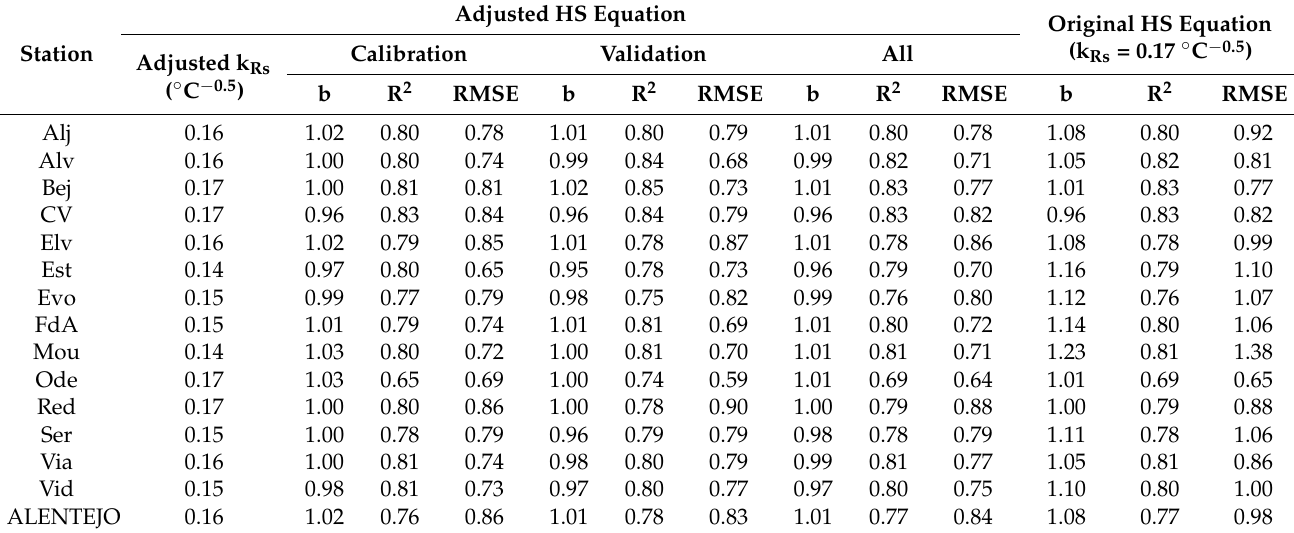
Table 4. Accuracy of daily reference evapotranspiration estimations using the Hargreaves equation after k Rs factor